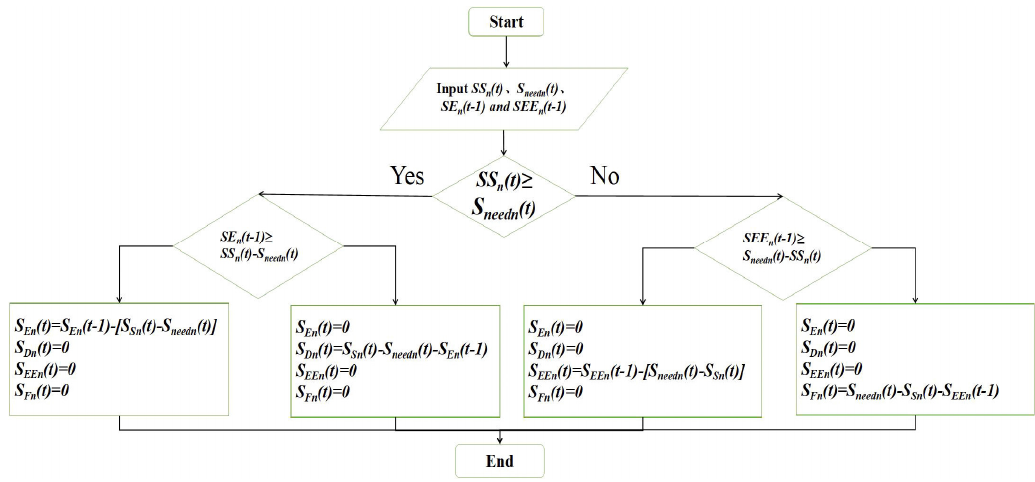
Figure 5. Flow chart of power deficit calculation.